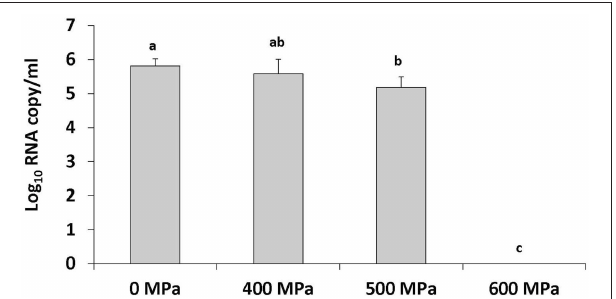
FIGURE 2 | Human NoV GII.4 inactivation in strawberry puree (pH 4) by increasing pressure levels. Treatment is at an initial temperature of 4 ◦ C with a holding time of 2min. Each bar represents average of three replicates ± 1 standard deviation.